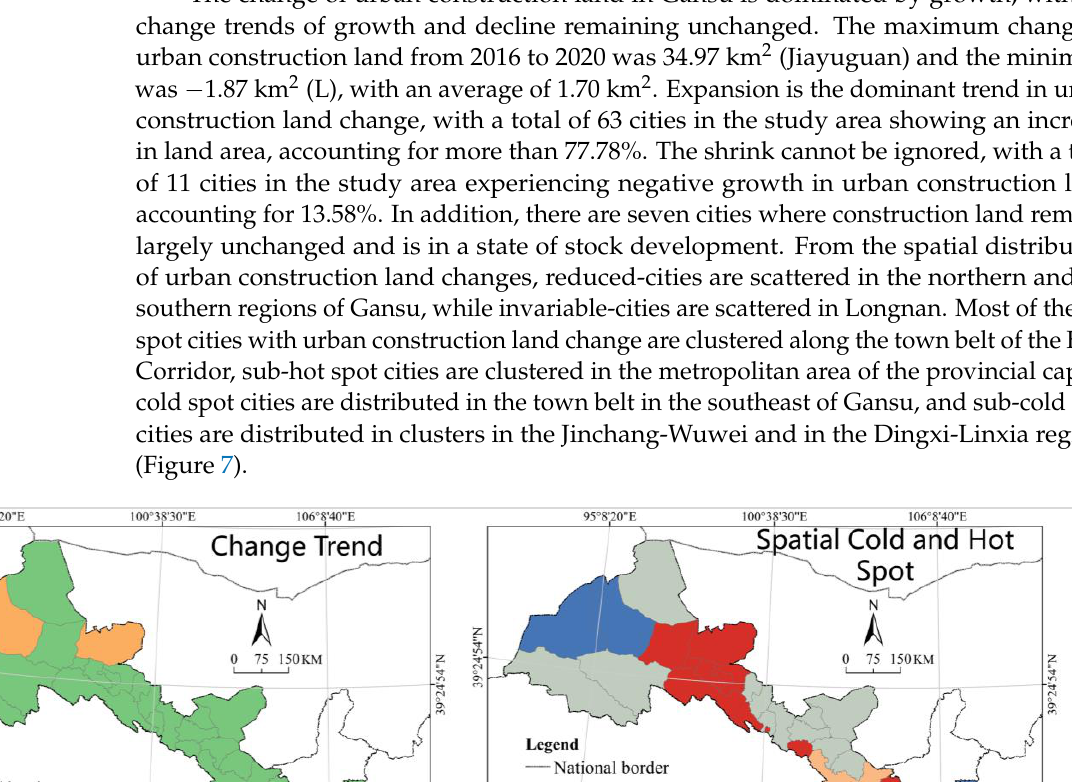
Figure 7. Analysis on the urban construction land change of